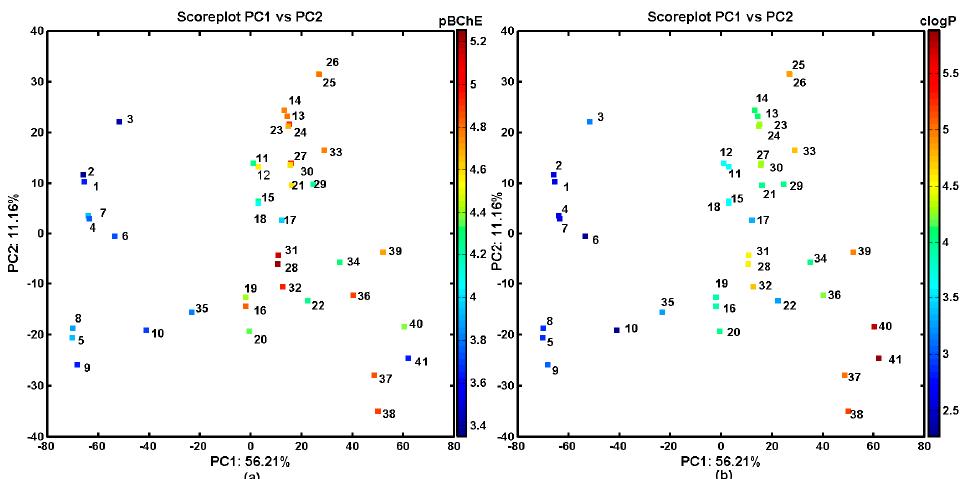
Figure 3. Projection of carbamates 1 – 41 on the plane defined by the first vs. second principal components with: BChE activity in the logarithmic scale ( a ); and the calculated lipophilicity profile ( b ). Colors indicate the numerical values of the pBChE activity and clogP.